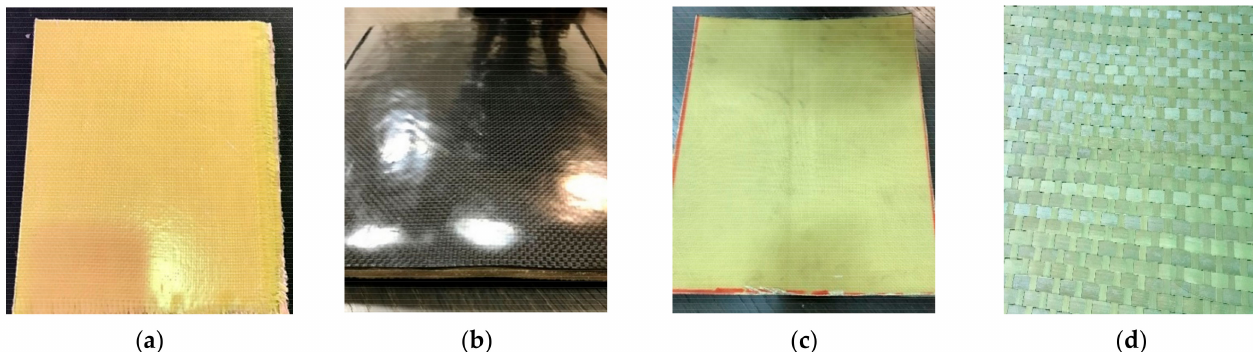
Figure 2. Examples of the fabricated body armor plates: ( a ) front-side of the flat non-hybrid [KFRP] 40 plates, ( b ) front-side of the curved hybrid [CFRP 10 /KFRP 30 ] plate, ( c ) back-side of the curved hybrid [CFRP 10 /KFRP 30 ] plate, and ( d ) untreated Qatari date palm